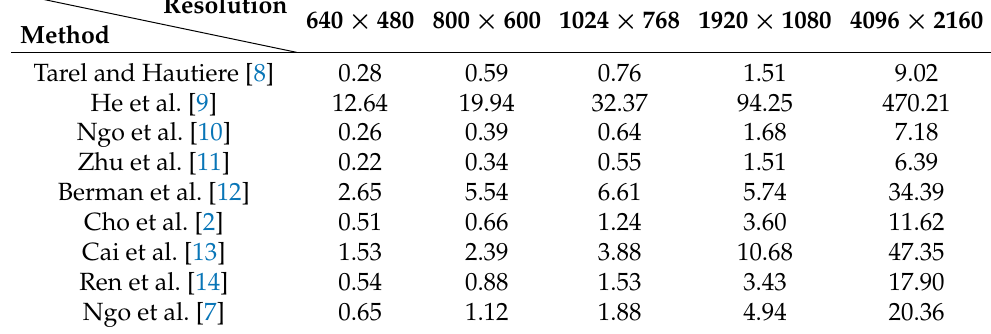
Table 1. Processing time in seconds of different image dehazing methods for different image